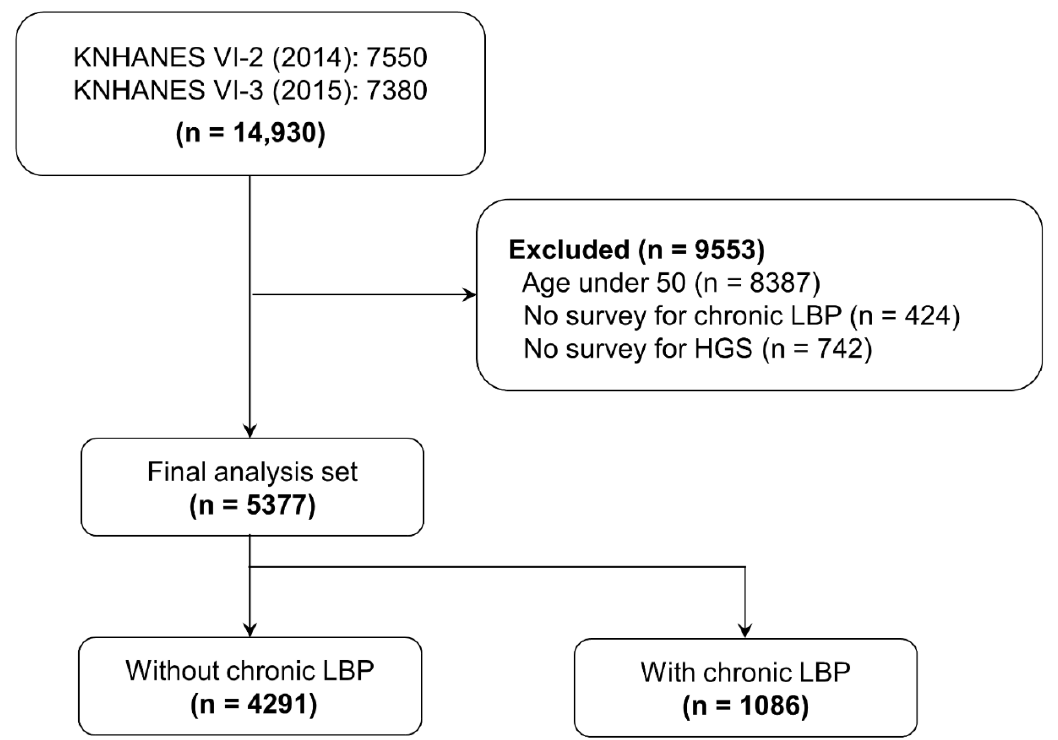
Figure 1. Flow of participants in 2014–2015 Korea National Health and Nutrition Examination Surveys.